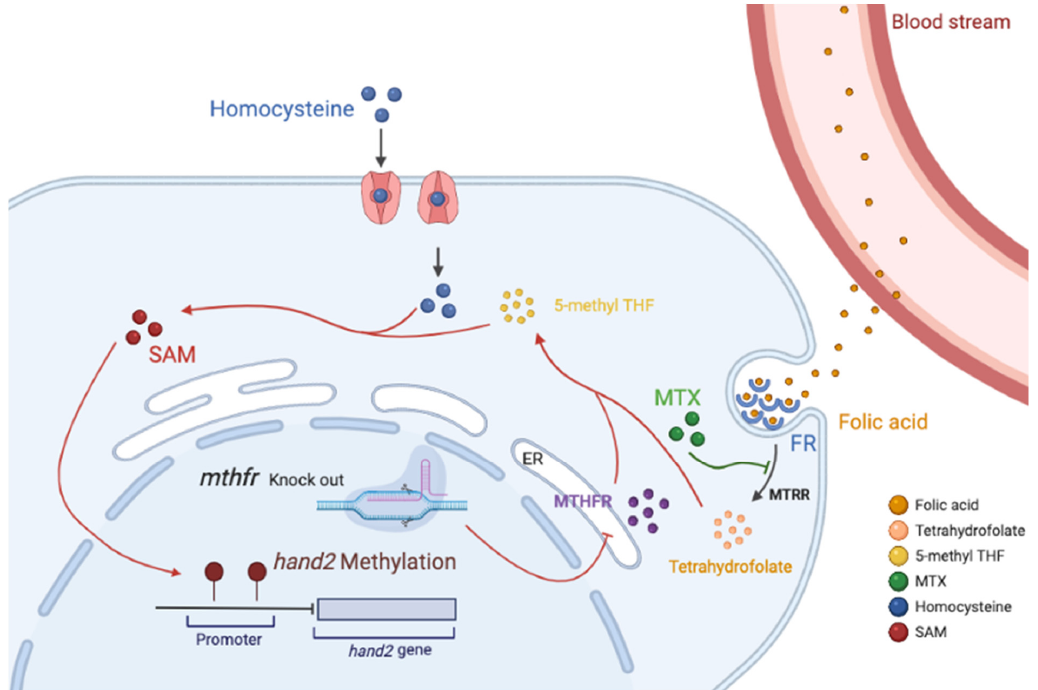
Figure 7. Model of folate dose-dependent regulation on zebrafish heart development . ER: Endoplasmic reticulum; FR: Folate receptor; SAM: S-adenosylmethionine; Folic acid enters the cell through the folate receptor and undergoes the met- abolic cycle. MTX specifically antagonizes MTRR, and knockout of the mthfr gene inhibits the endoplasmic reticulum synthesis MTHFR enzyme. These factors cause the conversion of folic acid to 5-methyl THF to be blocked, which reduces the efficiency of the conversion of homocysteine to methionine in the cell. Decreasing the content of methionine leads to a decrease in the content of DNA methylation donor SAM, which in turn affects the methylation of the hand2 promoter. This can lead to abnormal embryonic heart